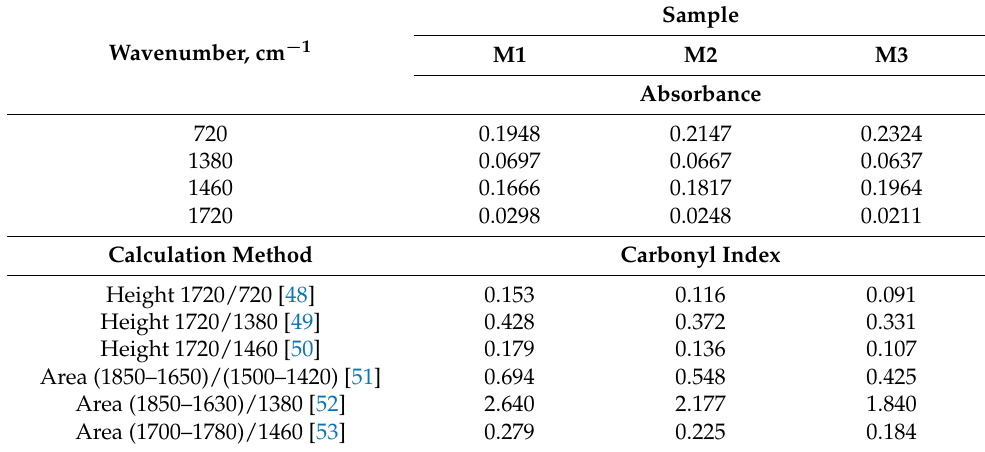
Table 2. Values of carbonyl index calculated for M1-M3 wastes according to the literature data [48–53].